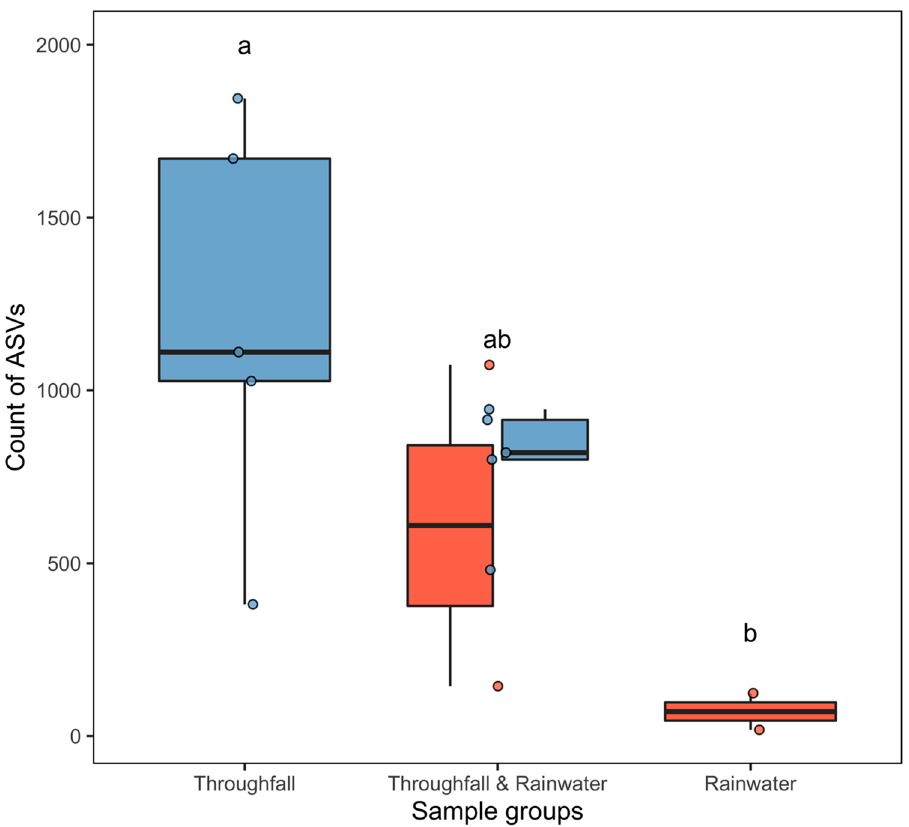
Figure 2. Box-and-whisker plots showing the difference in the count of unique ASVs detected among sampling groups: throughfall, throughfall and rainwater, and rainwater. Rainwater and throughfall treatments are shown in red and blue, respectively. Black lines denote medians, boxes represent 75% quantiles, red and blue dots show sample values, and lowercase letters indicate significant pair-wise differences (α =